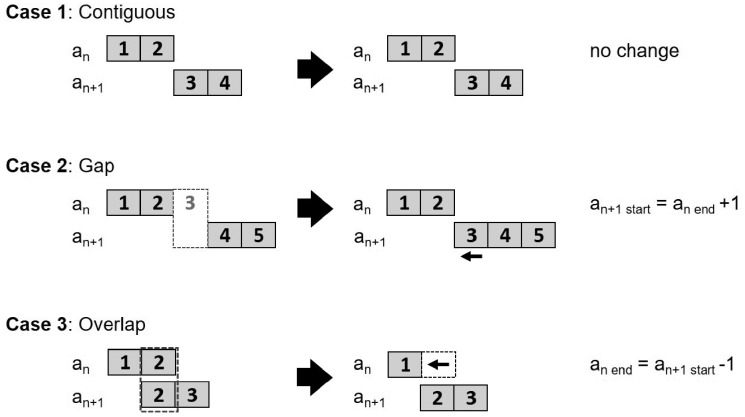
ALGAE’s conditions for cleaning address periods (an) derived from a contact database showing cases of: (i) contiguous address periods with complete information of address start (an start) and end (an end) dates; (ii) gaps in address periods where 1 or more days are missing; and (iii) overlap in address periods where one or more addresses are recorded for the same day for the same individual. In case of gaps or overlaps in address periods, ALGAE favours preserving the start date of address periods over end date.